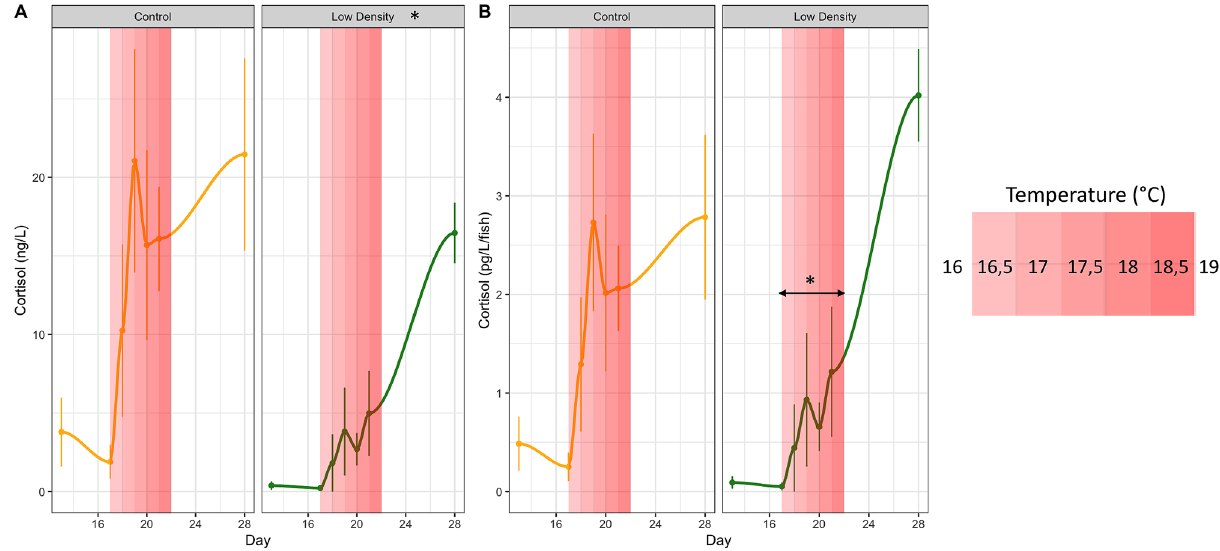
Figure 1. Cortisol production over time by European sea bass larvae reared at low or normal (Control) density and exposed to a gradual increase of temperature over 5 days. ( A ) Mean cortisol (ng/L) and ( B ) Mean cortisol produced per fish (pg/L/fish) represented by points (mean + SE), released into the water by developing larvae (from 13 to 28 dph) exposed to a gradual increase of temperature from 16 to 19 °C (0.5 °C per day from 17 dph, represented by red rectangles of increasing intensities). “*” indicates significant differences in cortisol release during the increases of temperature between the low-density treatment and the to control (p <